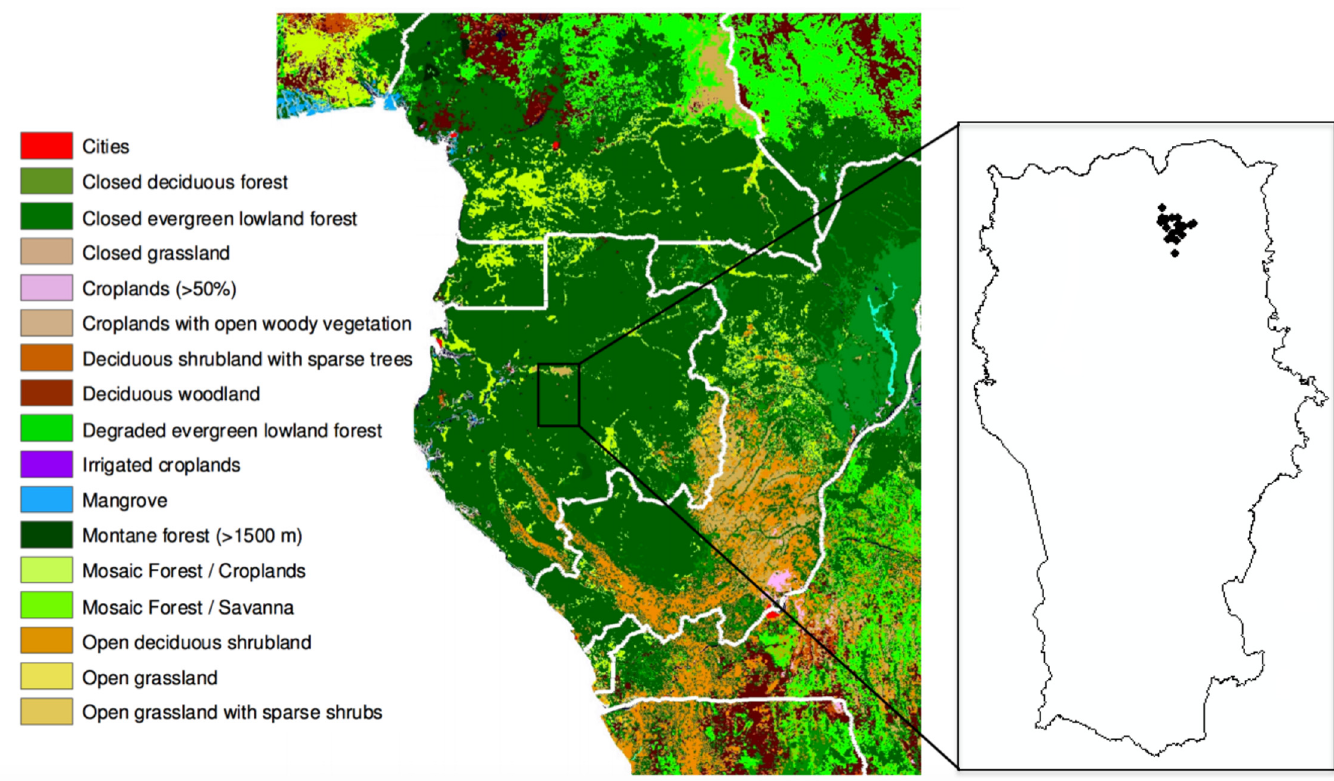
Fig 1. Lopé National Park (LNP) and plots sampled in the north of the park characterised by a savanna-forest mosaic. Map showing the location of the field site within a landcover map for the year 2000 [78] adapted from Mitchard et al. [21].